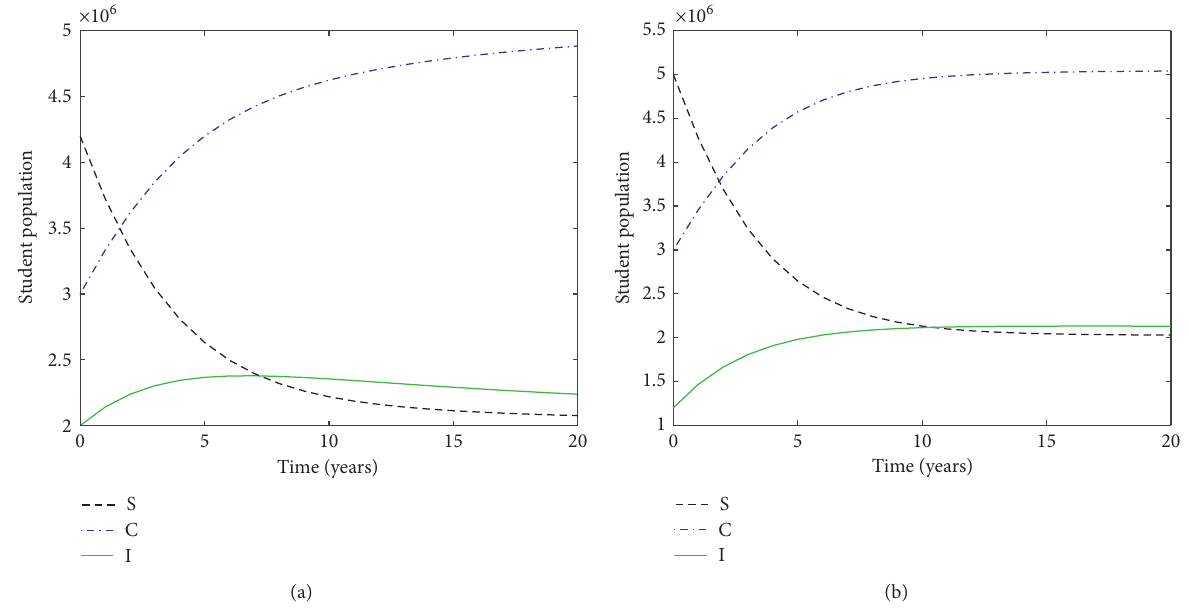
Figure 2: Simulation of the model showing the total number of Susceptible, Morally corrupt, and Immune as a function of time using initial conditions given in Section 2. Parameters used are in Table 2 with σ � 0, α � 0, and R